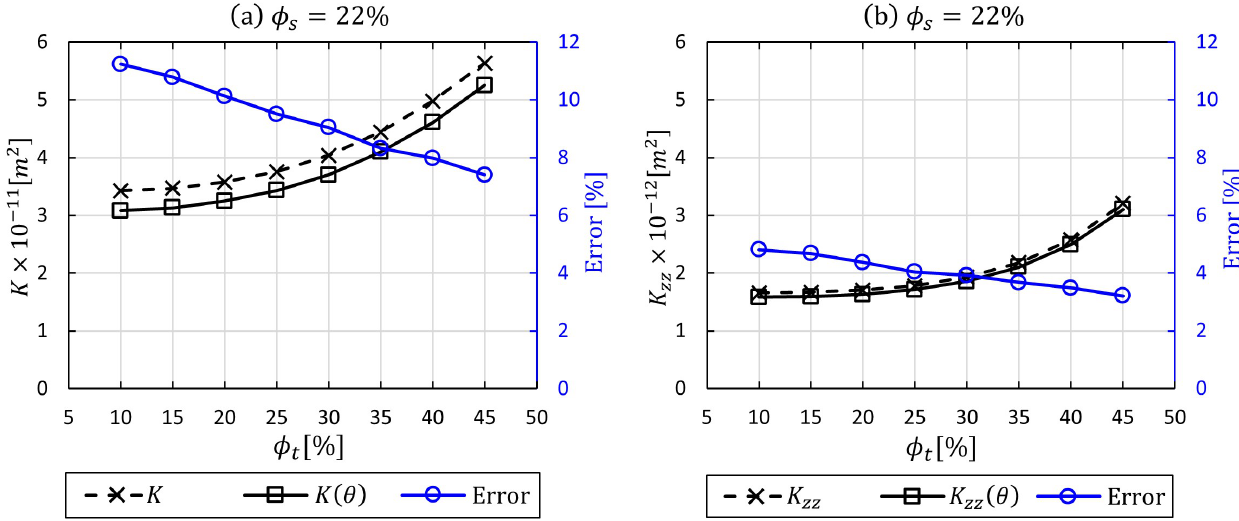
Figure 11. A comparative analysis of permeability with and without applying local curvature (0 ≤ θ ≤ 35) via UDF for flow throughout three-layer woven unit cell with nesting effect at inter-tow porosity ( φ s = 22%) with various φ t values: ( a ) in-plane permeability, ( b ) through-thickness